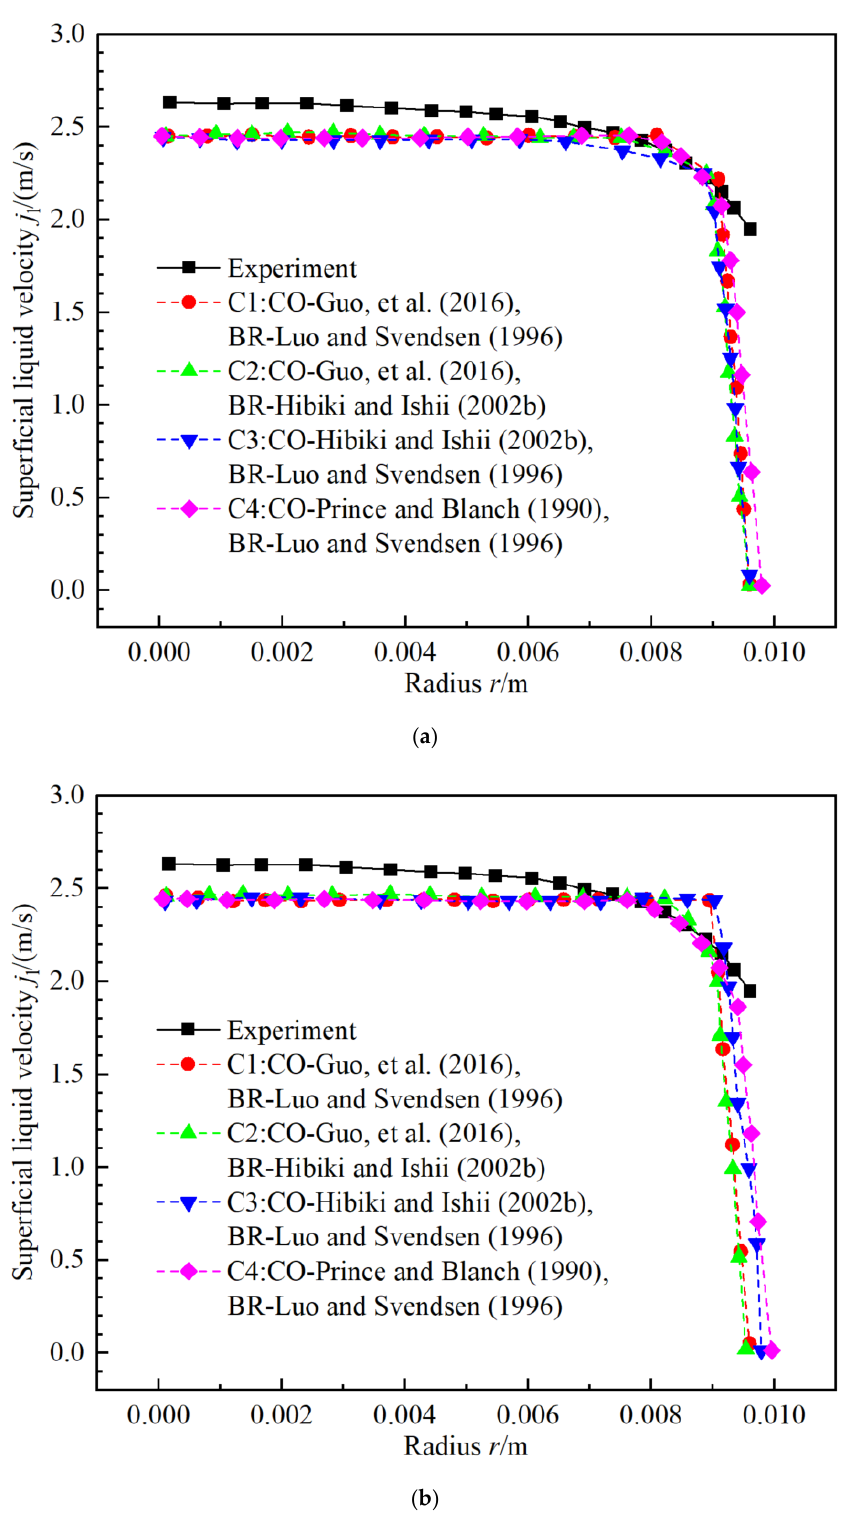
Figure 10. Superficial liquid velocity j l distribution of various combinations of coalescence and breakup kernel with model of D d [8], f [46] and DEBORA-1 experiment ( P = 2.62 MPa) [28] at z = 3.5 m. ( a ) with N n of Kocamustafaogullari and Ishii [36], and ( b ) with N n of Basu [40]. As shown in Figure 10b, except the near wall region, the maximum relative errors between four combinations of C1, C2, C3, and C4 under the N n model of Basu et al. (2002)